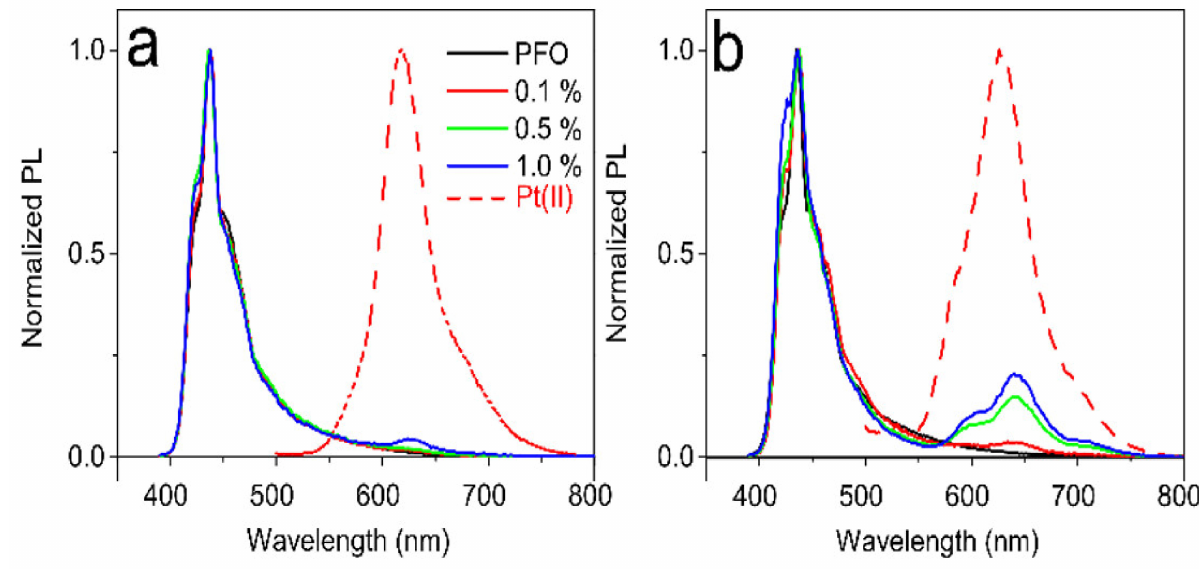
Figure 4. Normalized PL ( λ exc = 375 nm) spectra of the PFO composites. ( a ) [Pt(salophen)] and ( b ) [Pt(sal-3,4-ben)], with 0%, 0.1%, 0.5% and 1% mol/mol of